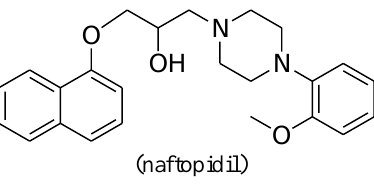
Figure 1. Structures of naftopidil.